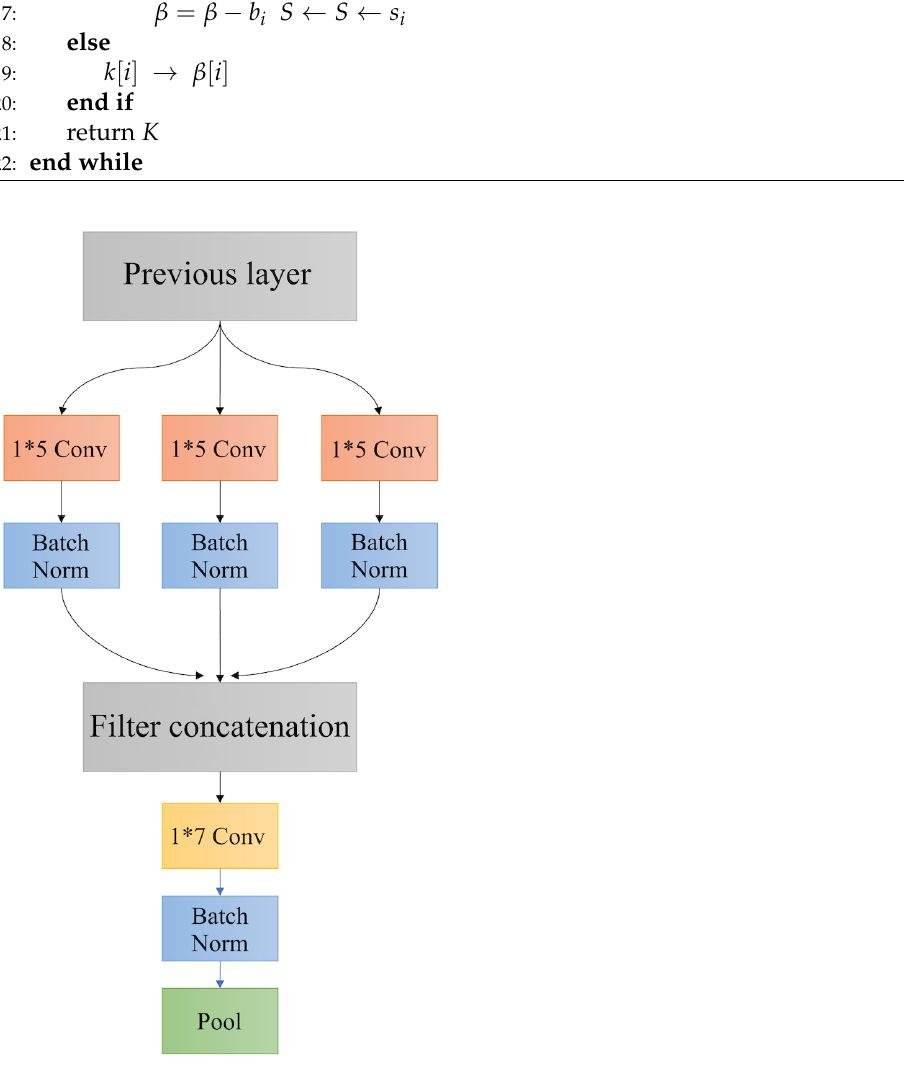
Figure 3. The structure of multi-stage channel feature extraction: Each convolution kernel is set up with 384, 640, and 1024 filters, respectively, to capture multi-stage channel